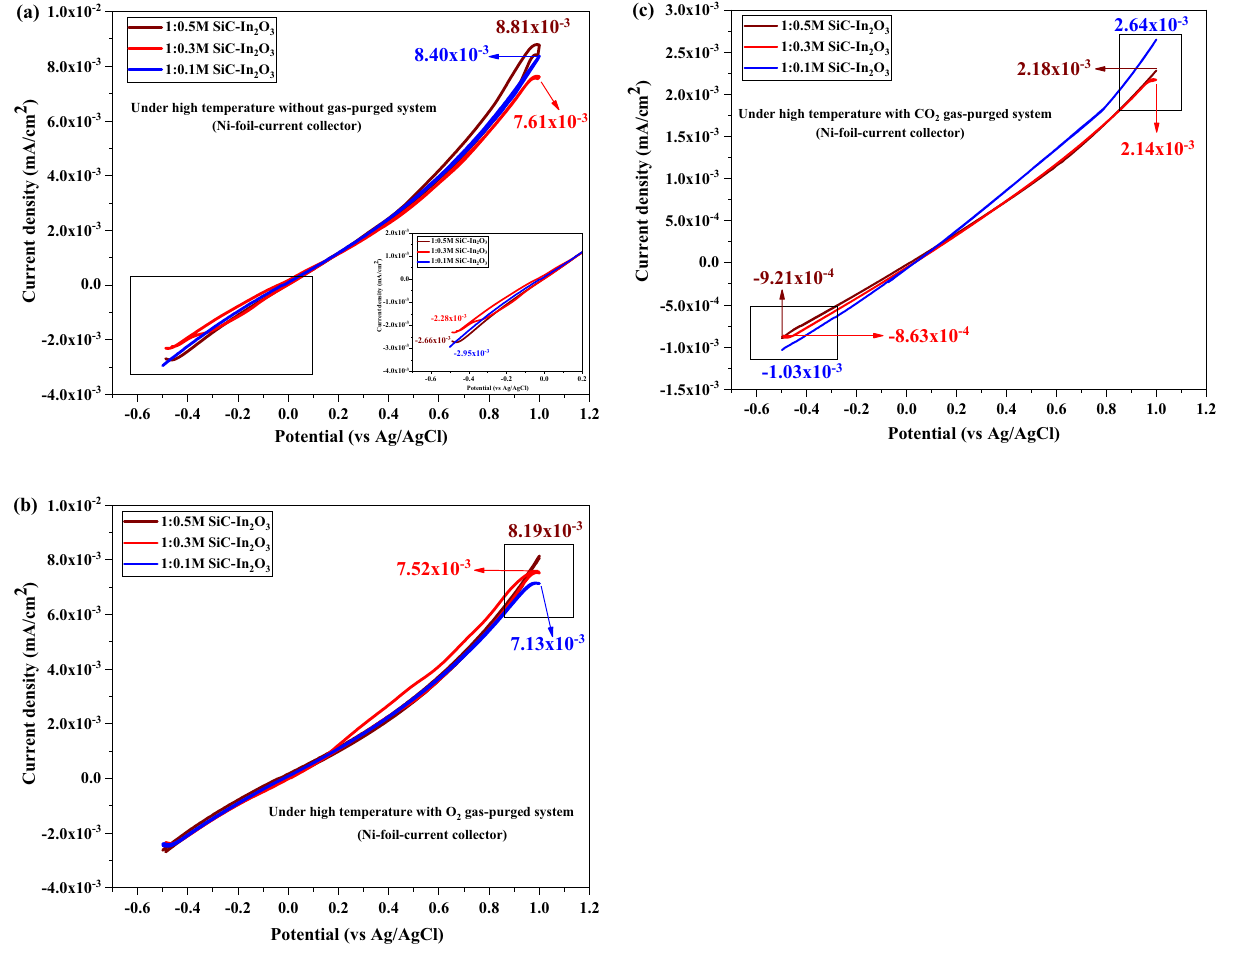
Figure 11. CV test of the as-prepared electrode under high temperature (350 °C) heat treatment with ( a ) without gas purging, ( b ) O 2 gas-purging and ( c ) CO 2 gas purging